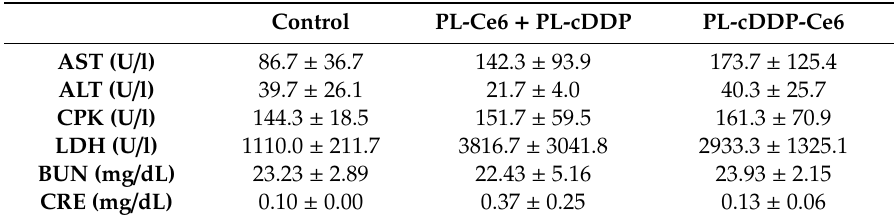
Table 1. Serum biochemical tests of aspartate aminotransferase (AST), alanine aminotransferase (ALT), creatinine kinase (CPK), lactate dehydrogenase (LDH), blood urea nitrogen (BUN), and creatinine (CRE). Data represented as mean ± SD of three mice per